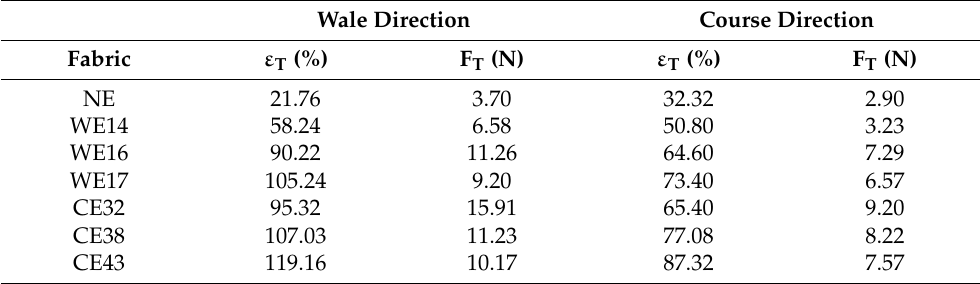
Table 5. Elongation values and corresponding force ( ε T , F T ) at the elastic limit for all knitted fabric